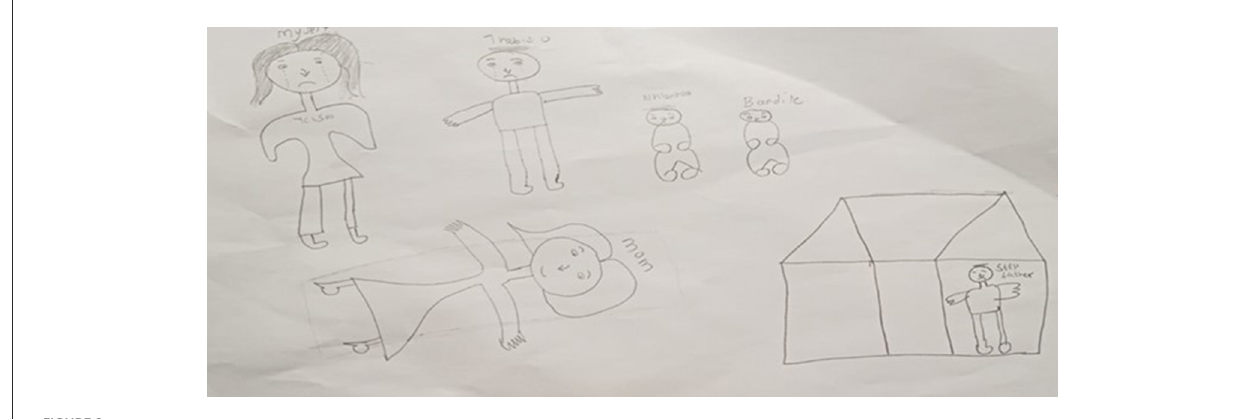
FIGURE2 Dream drawing on absent fathers, sick mothers, and resented